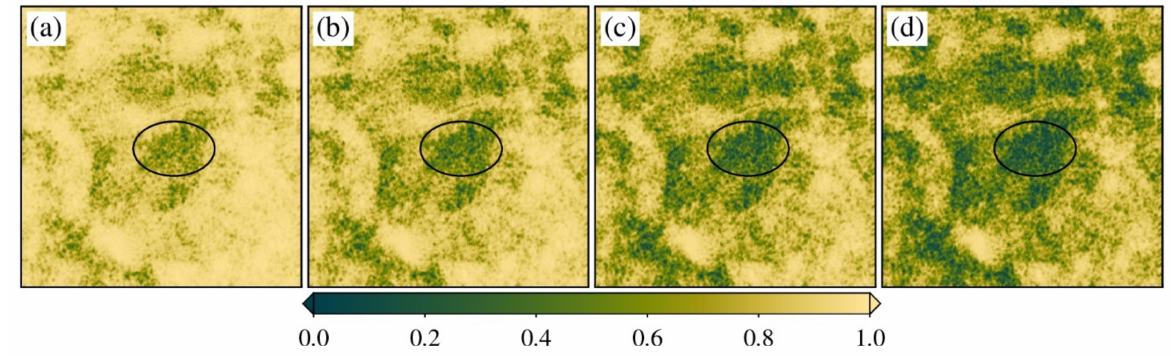
Figure 15. Coherence at four different noise levels. ( a – d ) Noise is continually increasing, and the coherence continually